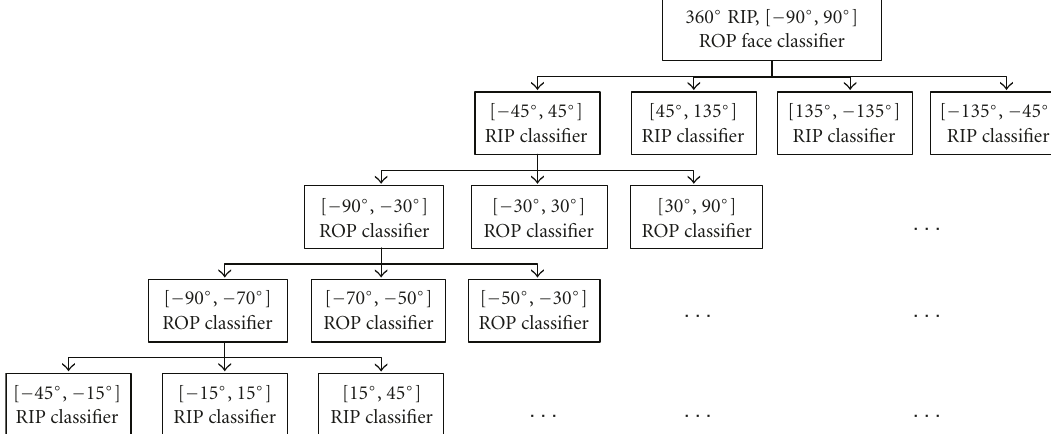
Figure 2: Illustration of the proposed fine-grained tree